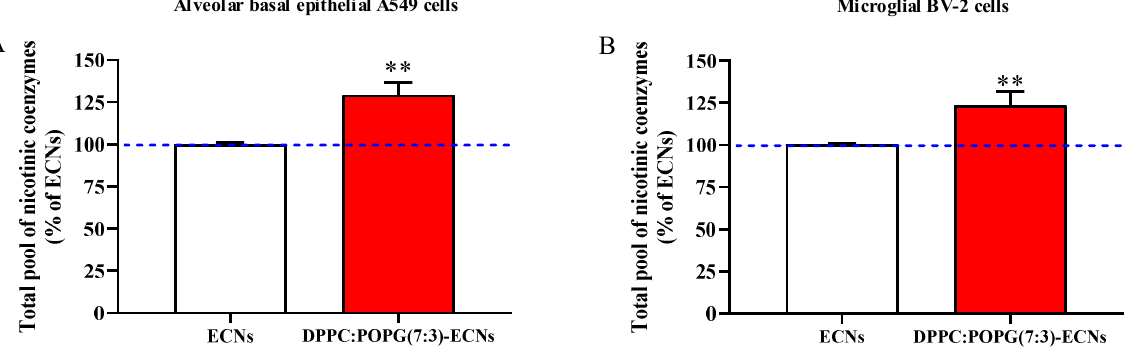
Figure 4. Total pool of nicotinic coenzymes (NAD+ + NADH + NADP+ + NADPH) in A549 ( A ) and BV-2 ( B ) cells following 24 h of ECNs (2 µg/mL) challenge without and with the LS DPPC:POPG(7:3) (indicated as DPPC:POPG(7:3)-ECNs). ECNs = engineered carbon nanodiamonds; DPPC = dipalmitoyl phosphatidylcholine; POPG = 1-palmitoyl-2-oleoyl-sn-glycero-3-phospho-(1 (cid:48) -rac-glycerol); NAD + = oxidized nicotinamide adenindinucleotide; NADH = reduced nicotinamideadenindinucleotide; NADP + = oxidized nicotinamideadenindinucleotide phosphate; NADH = reduced nicotinamideadenindinucleotide phosphate. Data are the mean of three independent experiments and are expressed as the percent variation with respect to the total pool of nicotinic coenzymes recorded in ECNs-treated cells. Standard deviations are represented by vertical bars. ** Significantly different from resting, p <